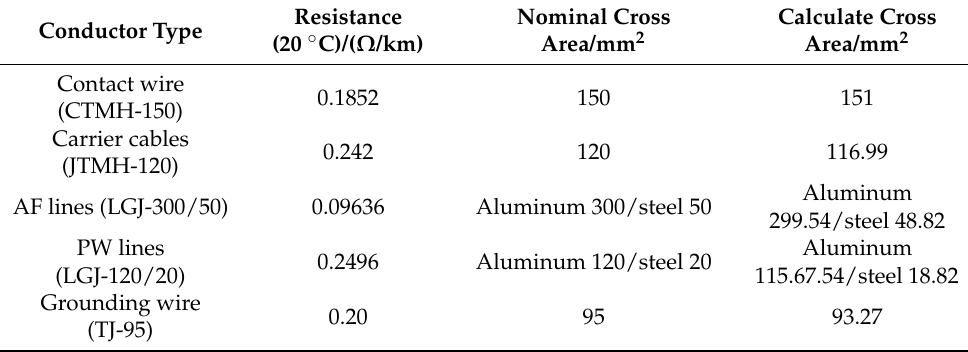
Table 2. AT power supply system parameters of each conductor.